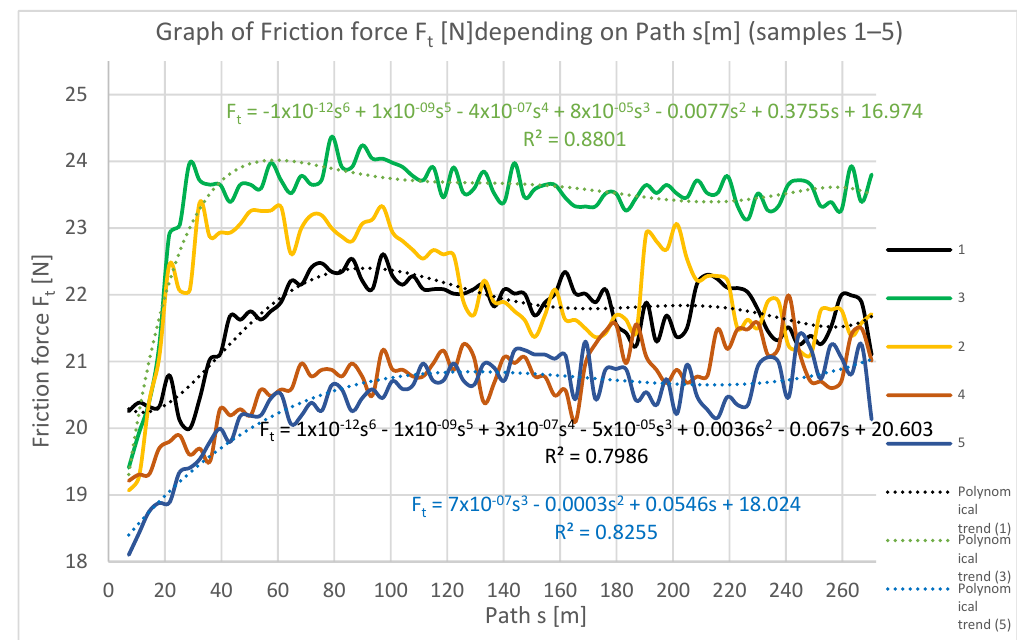
Figure 10. Plotted coefficient of friction depending on the path of Samples 1 – 5.